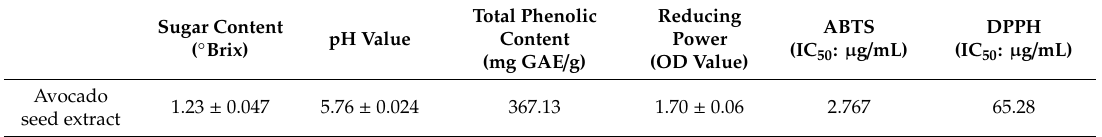
Table 2. The sugar content and pH value of avocado seed